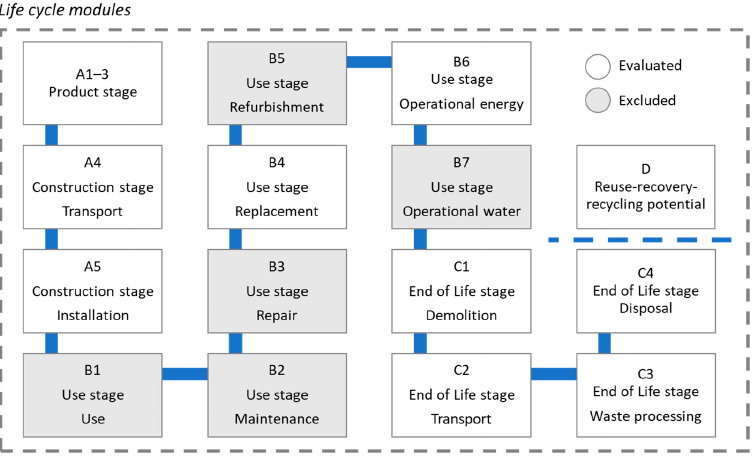
Figure 1. Modular approach for collecting information on the climate profile of the building district.